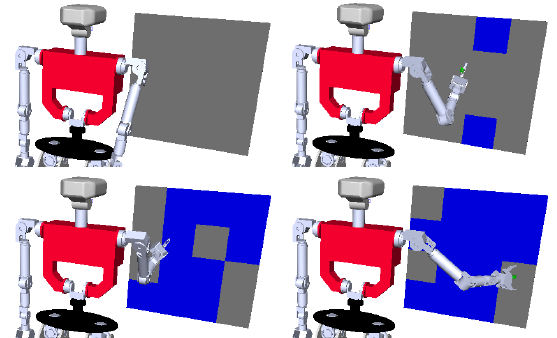
Figure 3. Execution of the “paint” action using the humanoid robot TEO inside a simulated